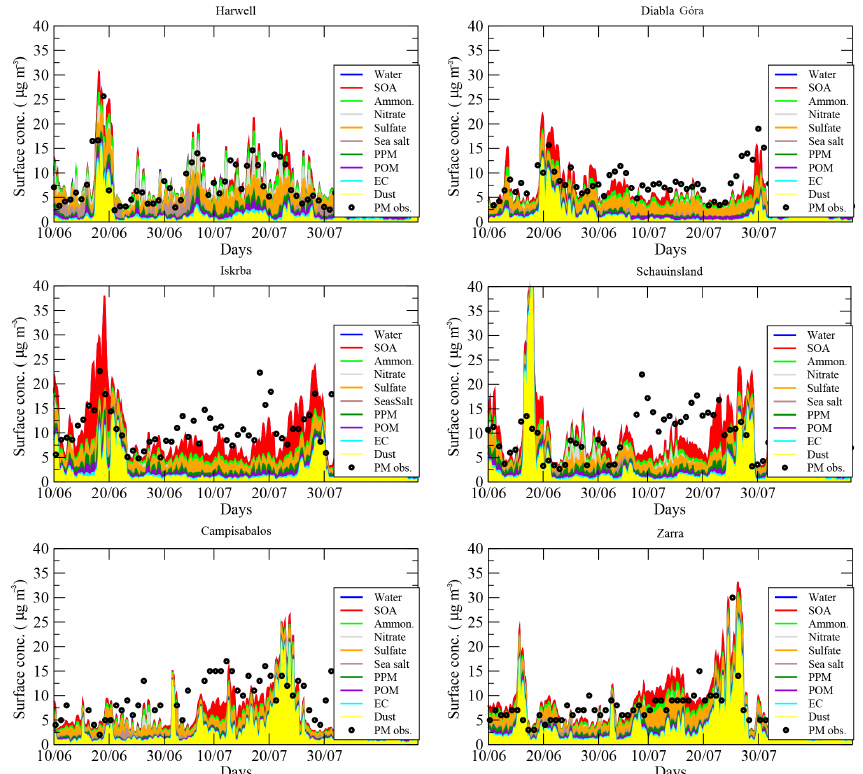
Figure 5. Time series of PM 2 . 5 (µgm − 3 ) with the model aerosol speciation. The colors represent all constituents of the modeled aerosol (for D p < 2 . 5µm) and the symbols represent the surface measurements of PM 2 . 5 .